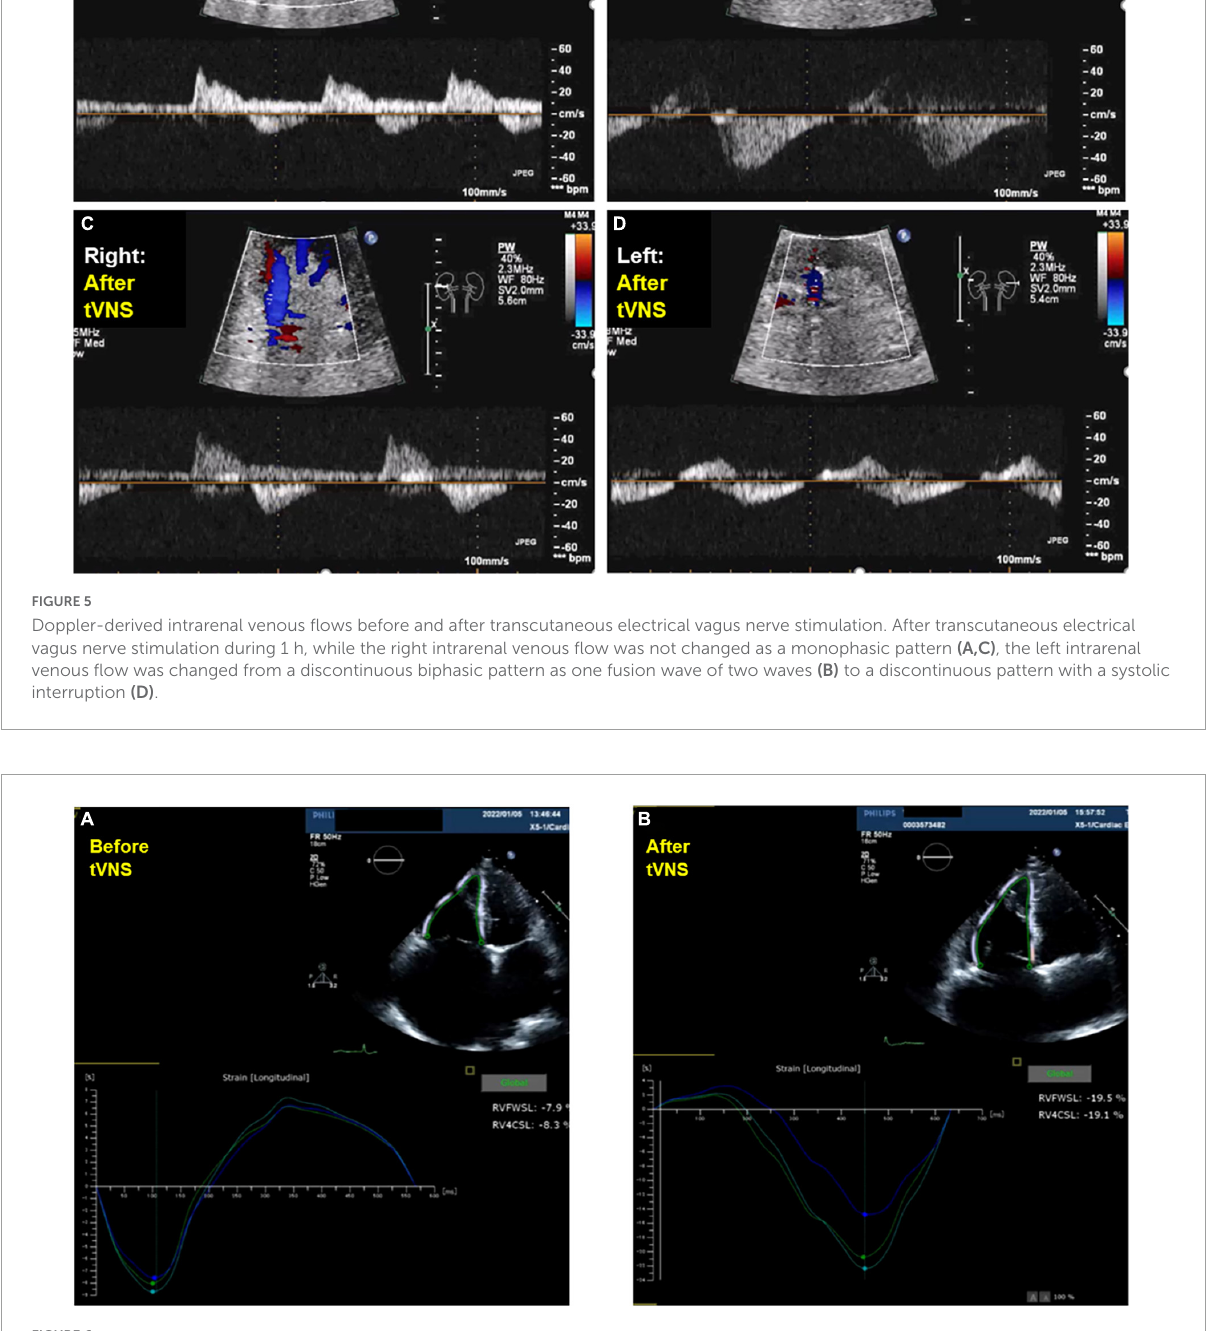
FIGURE6 Doppler-derived intrarenal venous flows before and after transcutaneous electrical vagus nerve stimulation. Right ventricular free-wall longitudinal strain and four chamber longitudinal strain were changed before (A) and after transcutaneous electrical vagus nerve stimulation during 1 h (B)